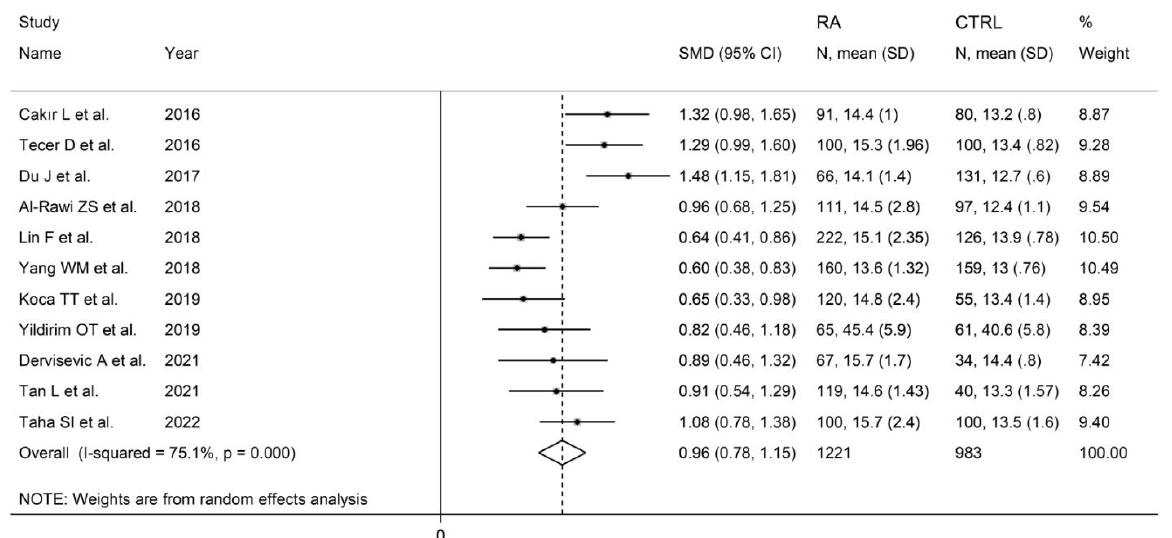
Figure 12. Forest plot of studies examining the red cell distribution width in patients with rheumatoid